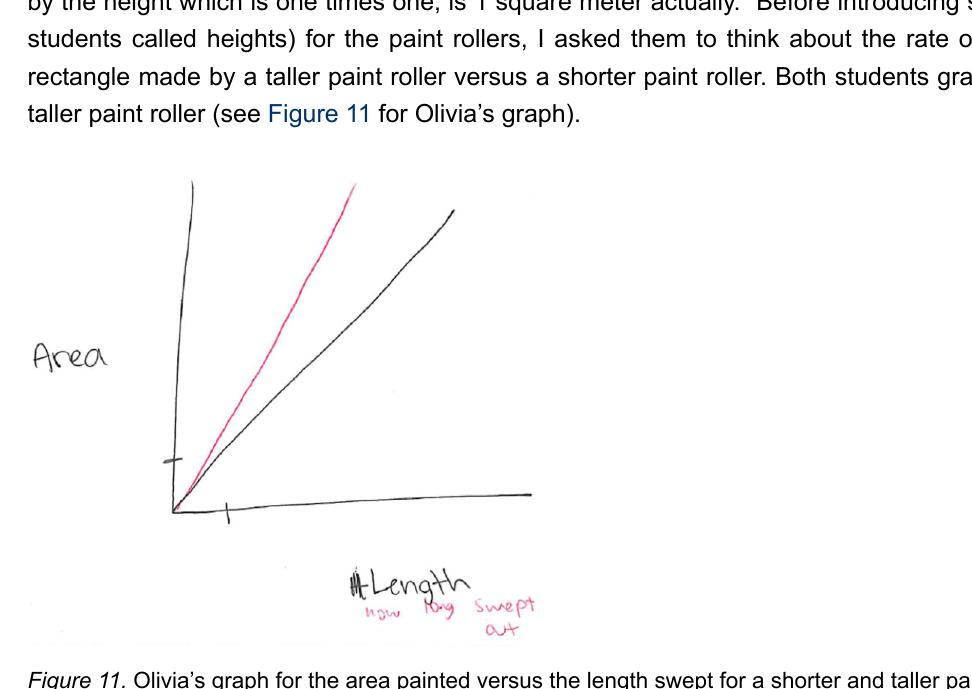
Wesley compared the second unspecified height to his original 1-meter paint roller, and explained, “Because since it’s, the height is bigger than 1 meter now, then for every length that you pull it out one meter, it gets more area.” Similar to Olivia’s unspecified length increments, Wesley thought about 1-meter increments and then could compare the amount of area being added for each rectangle while holding the length increment steady. Olivia compared the area swept (which she referred to as the height of the wall) to the slope, stating, “The steeper it is, the larger height of the wall it